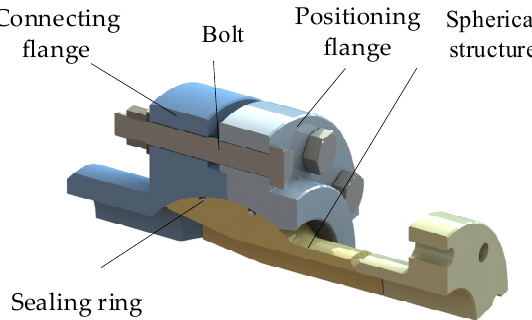
Figure 1. Diagram of the spherical structure.